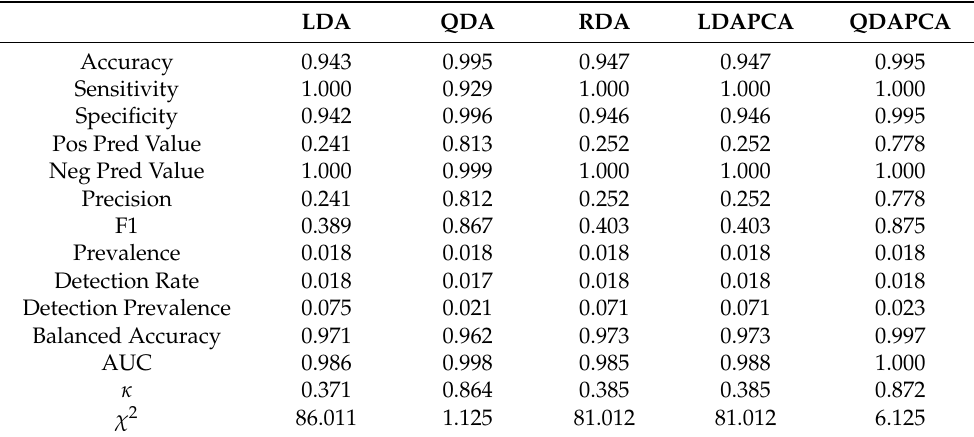
Table 3. Table of fit measures obtained for the reconstruction shown in Figure